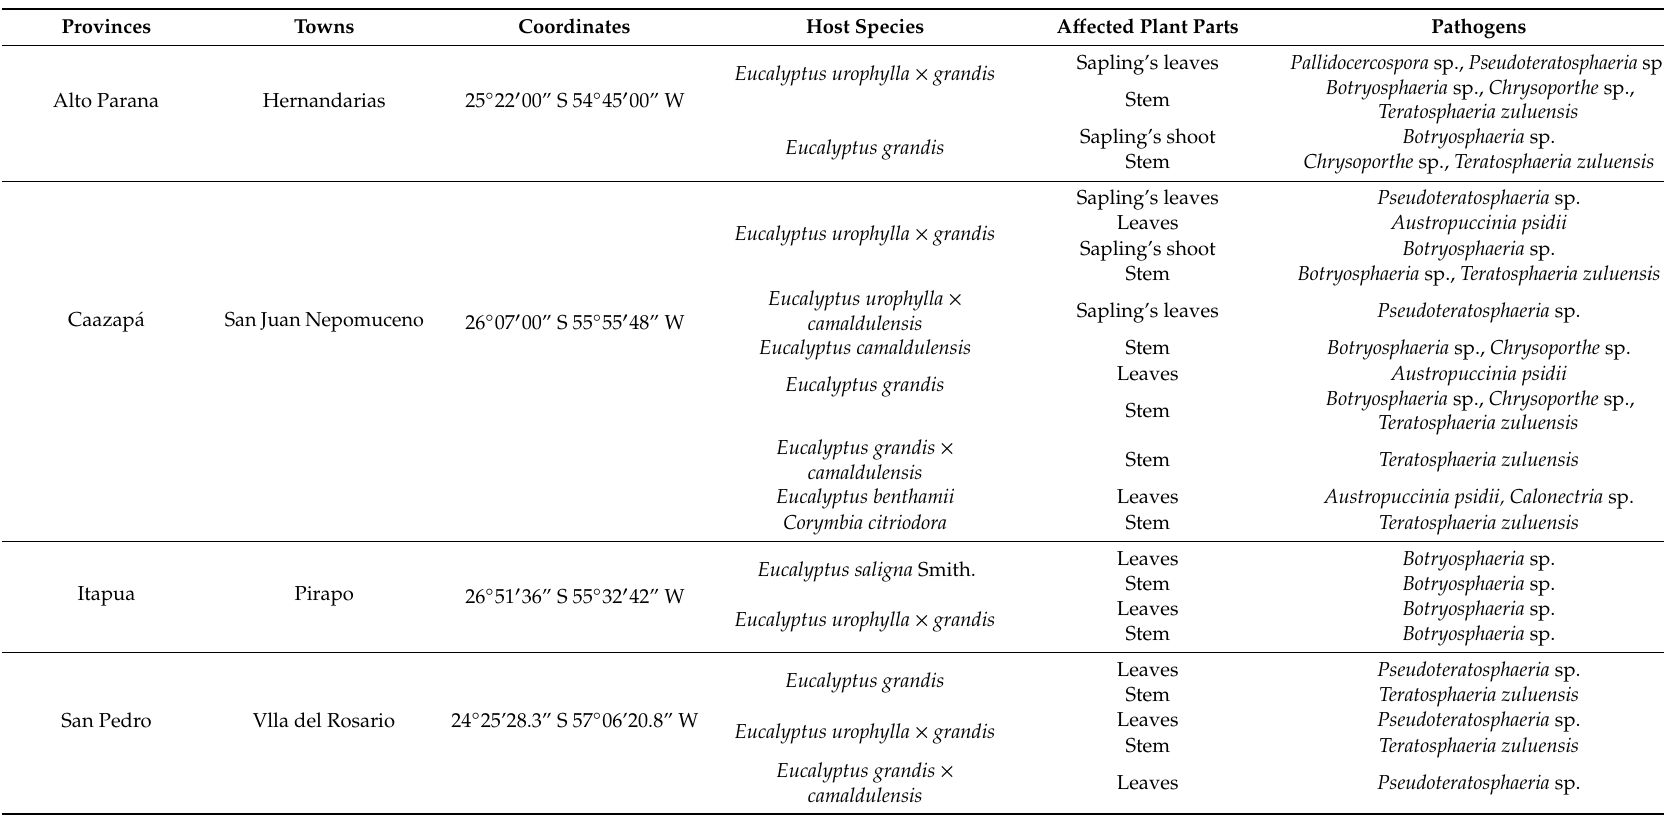
Table 1. Sampled eucalypts plantation areas in Paraguay, host species, a ff ected plant parts and fungal pathogens isolated from